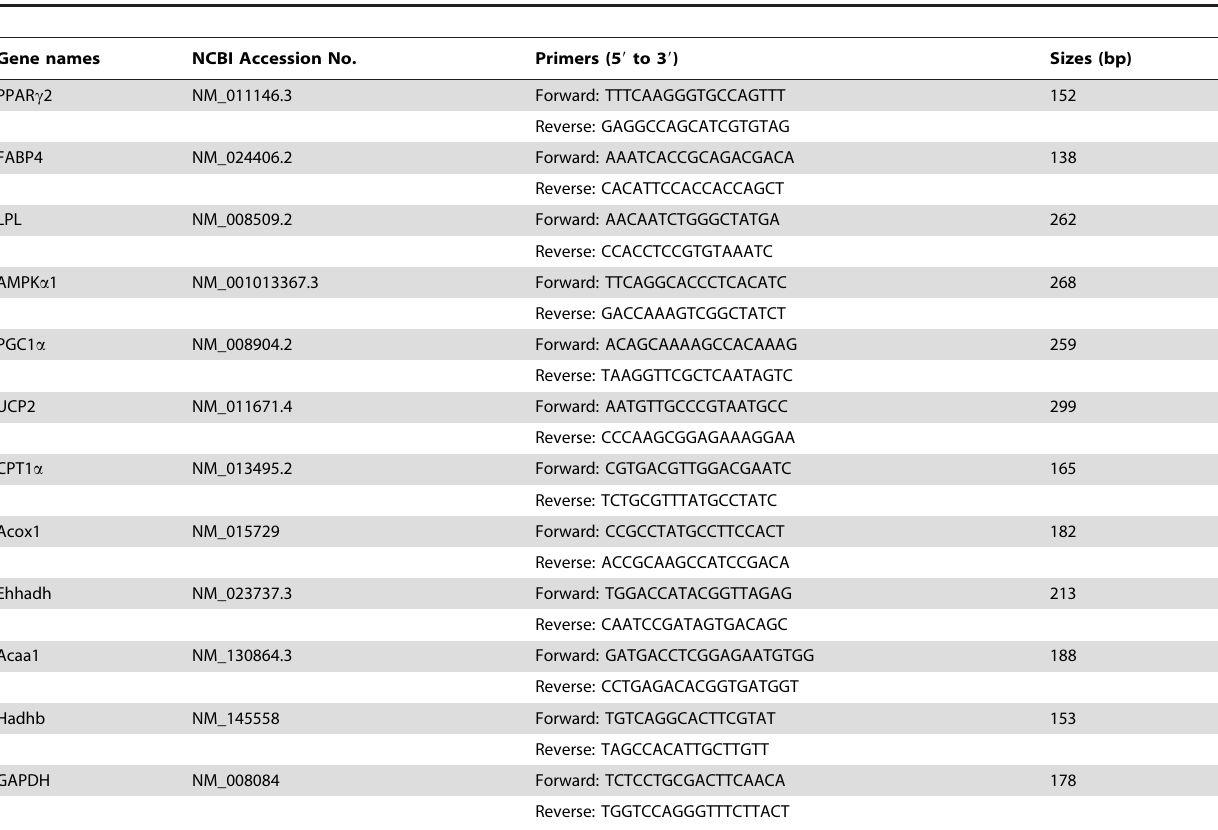
Table 3. Primers for energy metabolism